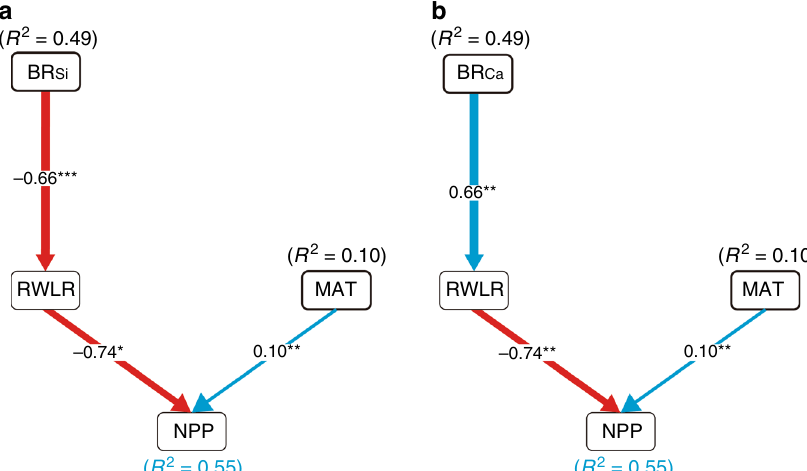
Fig. 4 Structural equation models of vegetation productivity. Two separated SEMs for the indirect effects of bedrock chemical elements (left: BR Si , right: BR Ca ) on NPP. The selection of explanatory variable terms in the results of single LMs and previous knowledge (Table 1). The blue arrows indicate positive effects, and the red arrows show negative effects. Standardized regression coef fi cients are given, with the thickness of the arrows expressing the size of the standardized regression coef fi cients. The R 2 values of each model (black) and the total effect of response variables (blue) are given between the brackets. Adjusted R -squared ( R 2 ) and levels of signi fi cance are shown (* p < 0.05, ** p < 0.01, *** p <